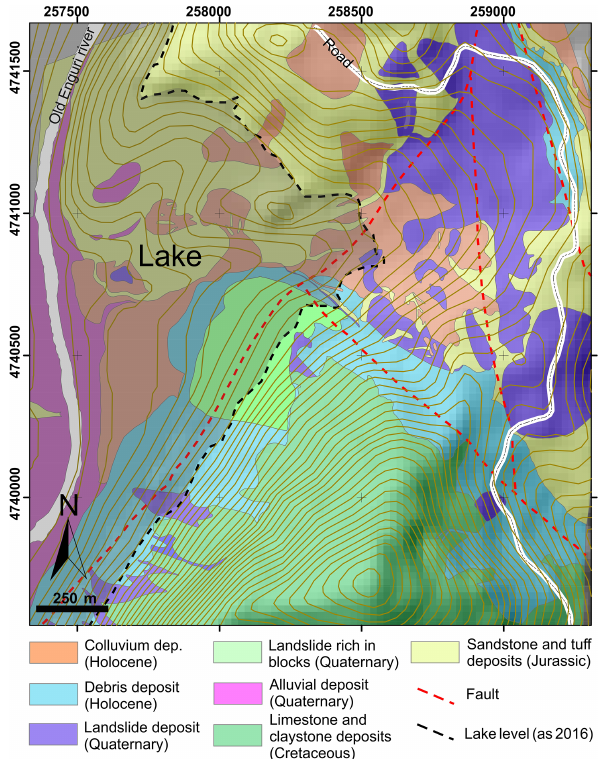
Figure 4. Geological map of the area surrounding the western land- slide, based on our new field surveys in the onshore zone and data from Zolotarev et al. (1968) for the zone now submerged by the Enguri water reservoir.